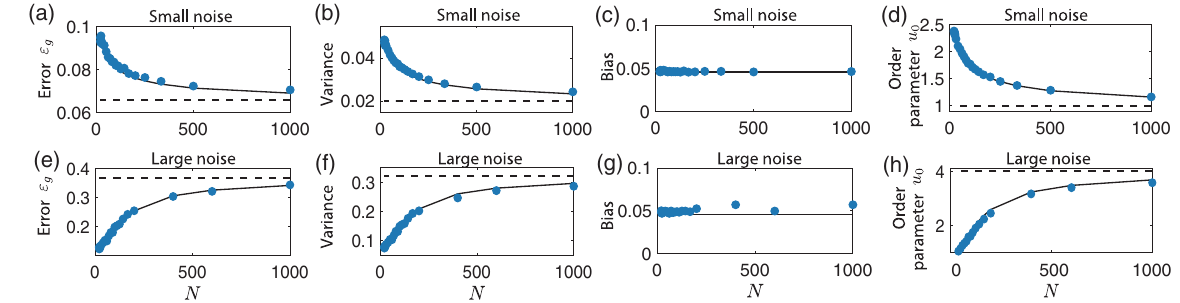
FIG. 11. Single hidden-layer ( L ¼ 1 ) ReLU network trained on the template model with labels generated by a noisy linear teacher with details of parameters in Appendix E. (a,e) Generalization error, (b,f) variance, (c,g) bias of the predictor, and (d,h) the order parameter u 0 as a function of N . Black solid lines: theory. Blue dots: simulation. Black dashed lines: GP limit ( N ¼ ∞ ). (a) – (d) Results in the small- noise regime where the generalization error decreases with N . (e) – (h) Results in the large-noise regime where the generalization error increases with N .